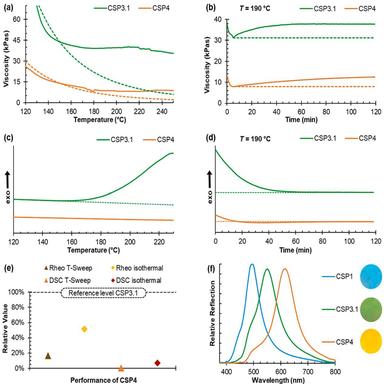
Comparison of the thermal stability of the optimized batch CSP4 to state-of-the-art particles. (a) Temperature-dependent rheological examinations in ambient atmosphere in terms of dynamic complex viscosities. In a temperature range from 35 ◦C to 165 ◦C measured viscosities were fitted to Arrhenius-Law and extrapolated for temperatures > 165 ◦C. (b) Isothermal rheological examinations in ambient atmosphere. The minimum viscosity after heating to 190 ◦C is sketched as a horizontal dotted line. (c-d) Temperatu